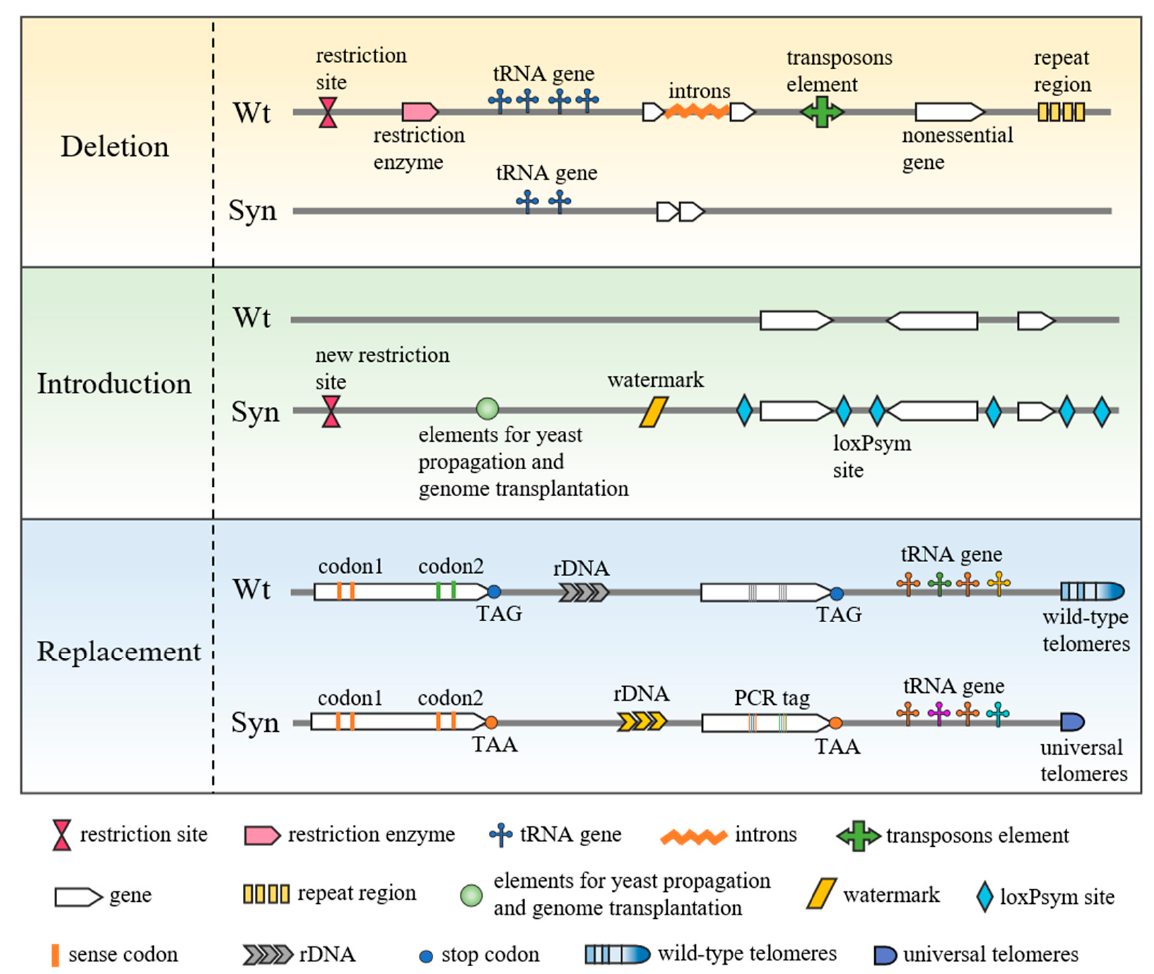
Figure 1. General design principles of synthetic genomes. Nonessential sequence is deleted. Elements are introduced which are required to assemble or research. Replacements are designed according to the purpose of the study.